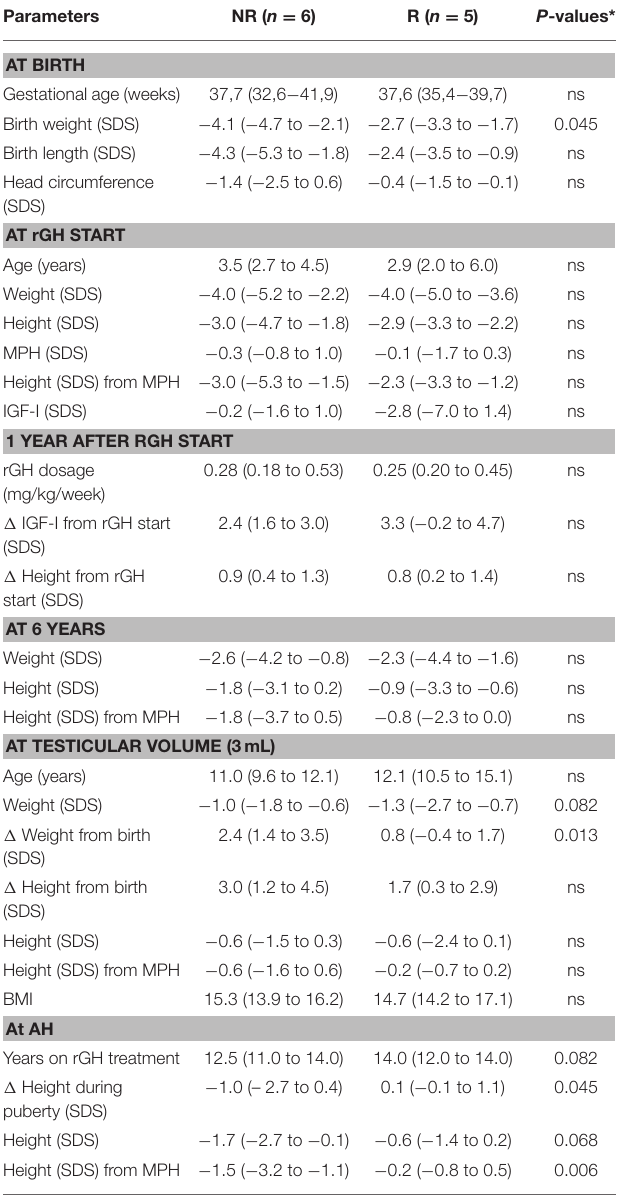
TABLE 3 | Clinical data [median (range)] for non-responders (NR) and responders (R).